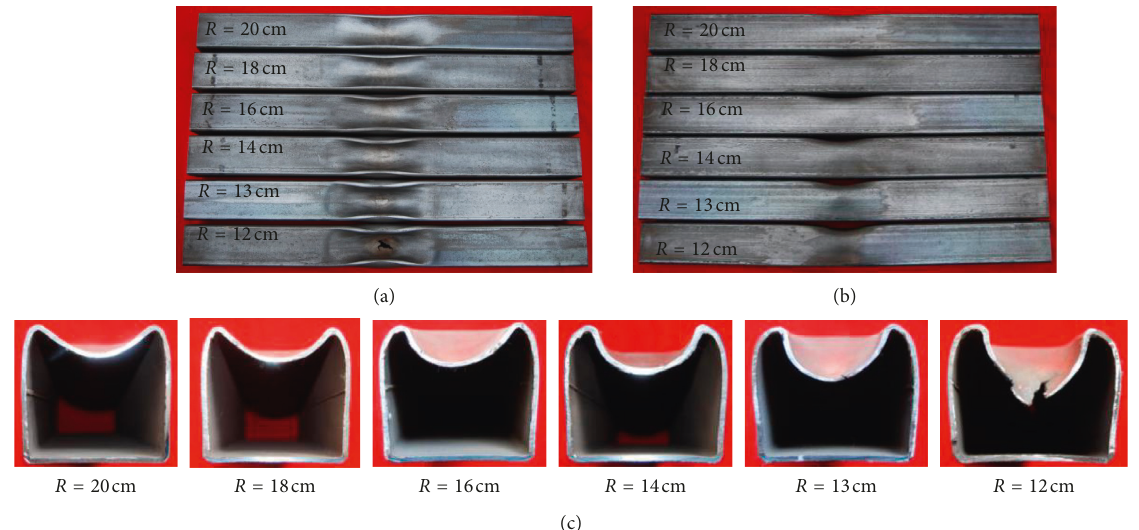
Figure 14: Damage of square tubes with a thickness of 4.0mm at different stand-off distances. (a) Planform view. (b) Side view. (c) Cross